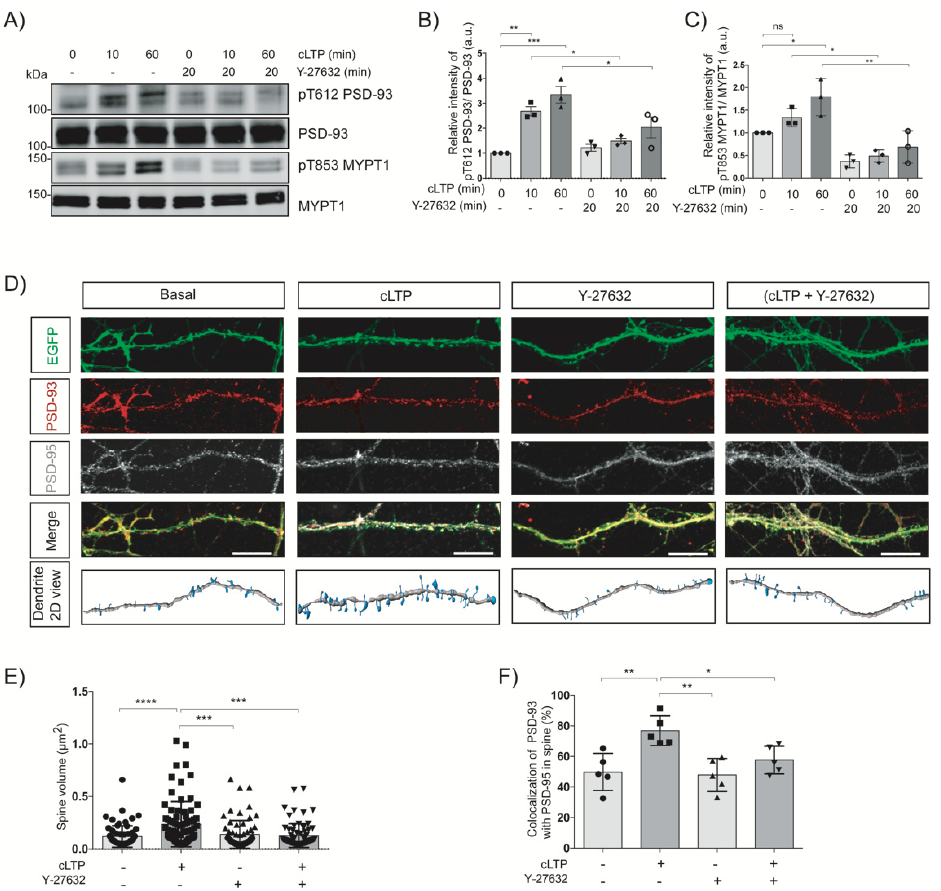
Figure 6. Chemically induced-LTP increases the Rho-kinase-mediated phosphorylation of PSD-93 and the colocalization of PSD-93 with PSD-95. ( A ) Chemical-LTP induces the PSD-93 phosphorylation in cultured striatal neurons. Striatal neurons were cultured until DIV21 and then neurons were treated with glycine (200 µM) after pretreatment with the Rho-kinase inhibitor Y-27632 (20 µM). The samples were analyzed by immunoblot analysis of anti-pT612 PSD-93, anti-PSD-93, anti-pT853 MYPT1, and anti-MYPT1 antibodies. ( B , C ) The horizontal lines represent the mean ± SEM of three independent experiments. *, ** and *** represent p < 0.05, p < 0.01, p < 0.001, respectively, and “ns” denotes “not significant”, for Tukey ’ s multiple comparisons test. ( D ) Colocalization of PSD-93 with PSD-95 during chemical-LTP in cultured primary striatal neurons. The neurons were cultured until DIV14 and infected with AAV-EGFP and AAV-Cre virus. After DIV21, the neurons were treated with glycine to induce chemical-LTP and the immunostaining was performed with anti-GFP (green), anti-PSD-93 (red) and anti-PSD-95 (white) antibodies. The scale bar is 10 μ M. ( E , F ) The horizontal lines represent the mean ± SEM of five independent experiments. *, **, *** and **** represent p < 0.05, p < 0.01, p < 0.001 and p < 0.001, respectively, for Tukey ’ s multiple compari- sons test.